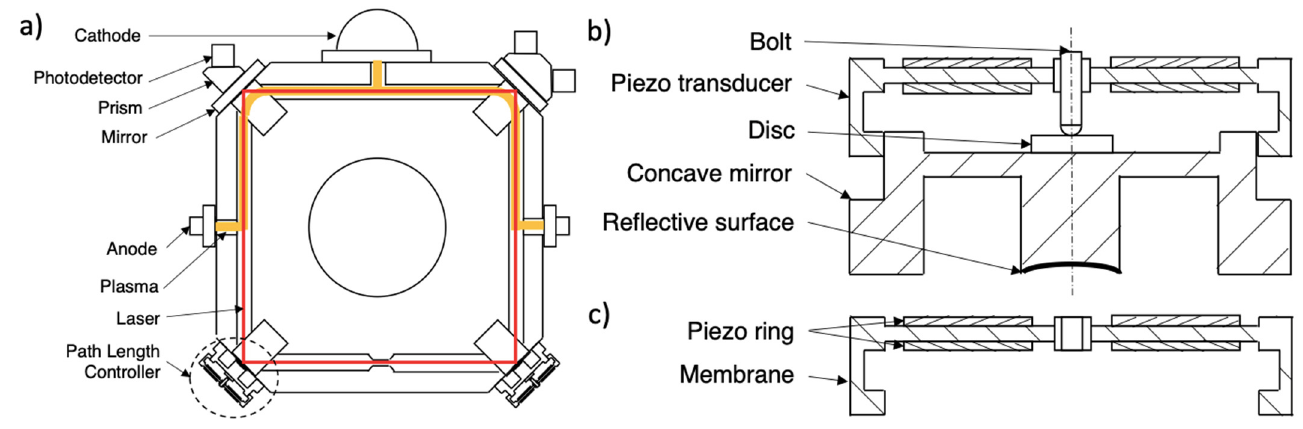
Figure 1. Schematics of ( a ) RLG structure, ( b ) PLC structure and ( a , c ) piezo transducer. Adapted from ref. [17].